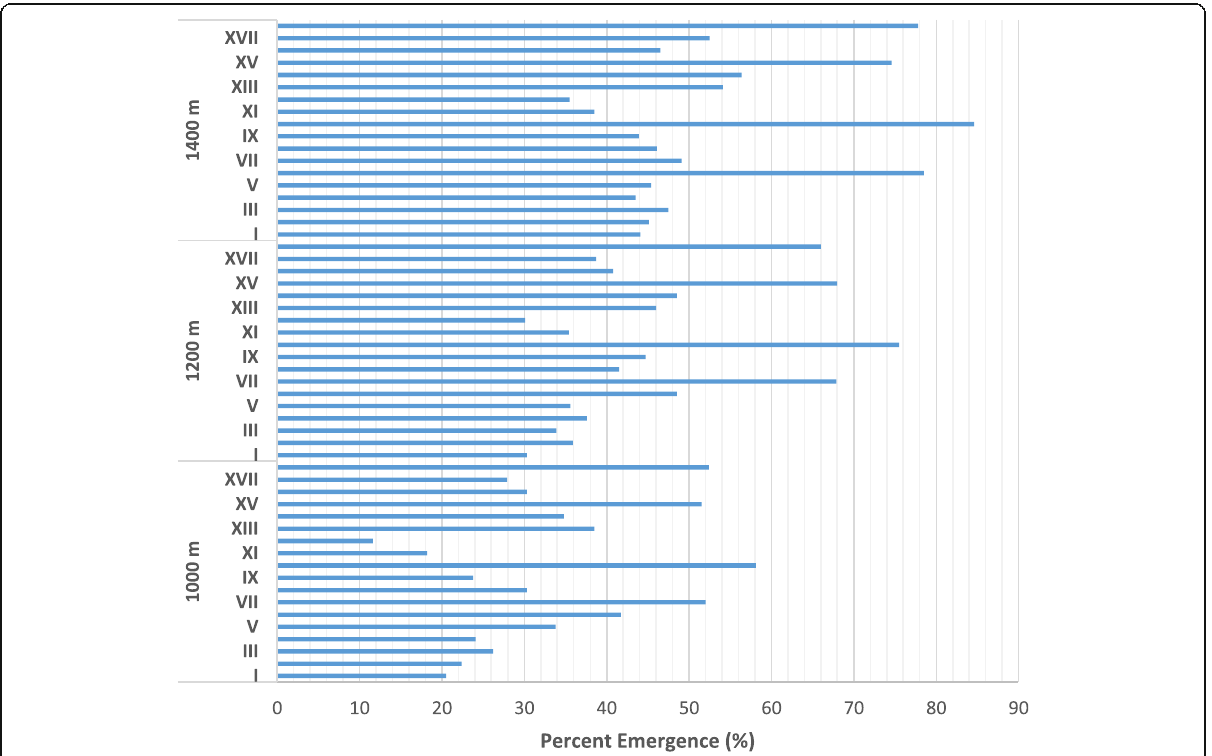
Fig. 1 Percent emergence of the seedlings by altitudes and pretreatments (control is the number